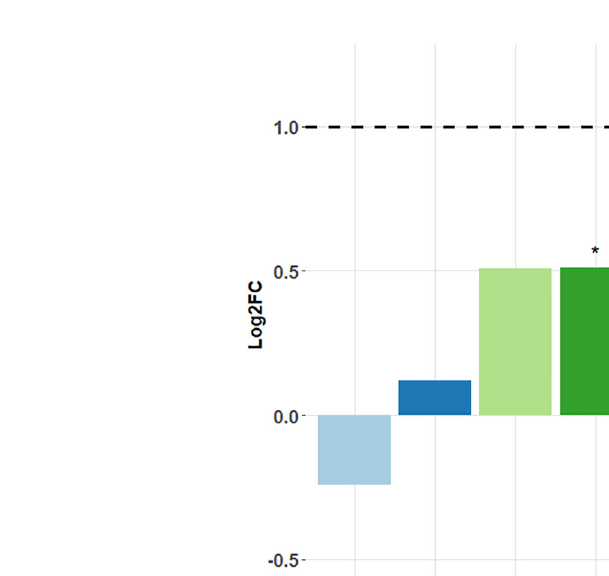
TABLE 3 Log2 transformed expression levels of the selected target genes for the sensitised rats and non-sensitised controls. Non-sensitised